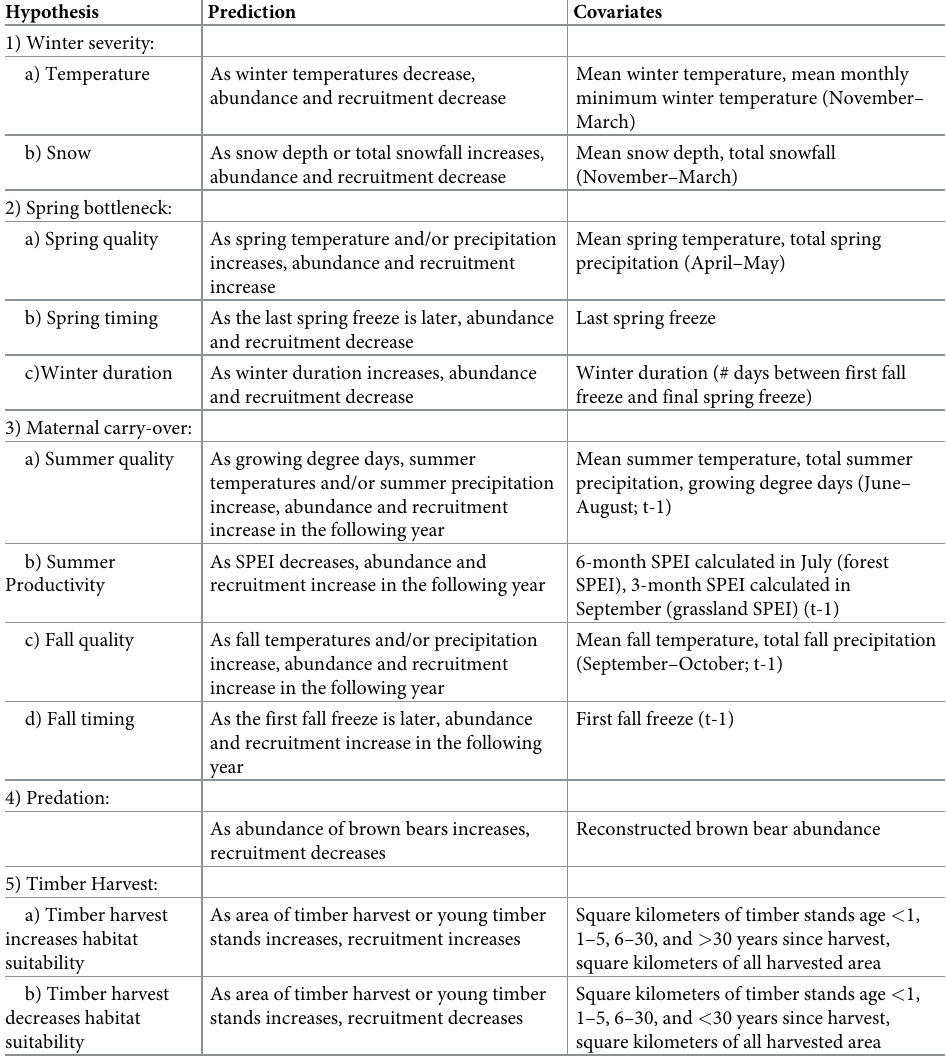
Table 1. Hypotheses, predictions, and covariates used to estimate factors influencing elk abundance and recruitment. Hypothesis